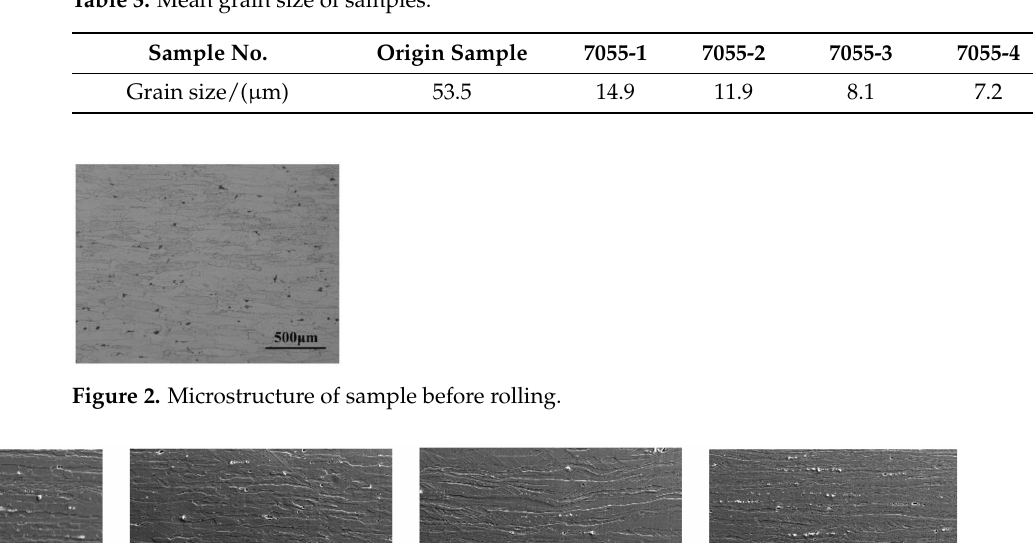
Table 3. Mean grain size of samples.